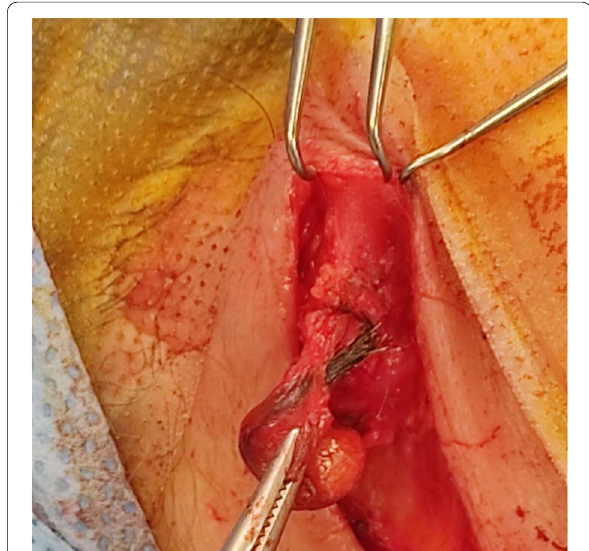
Fig. 3 The excised cyst wall with a tuft of hair inside the cyst